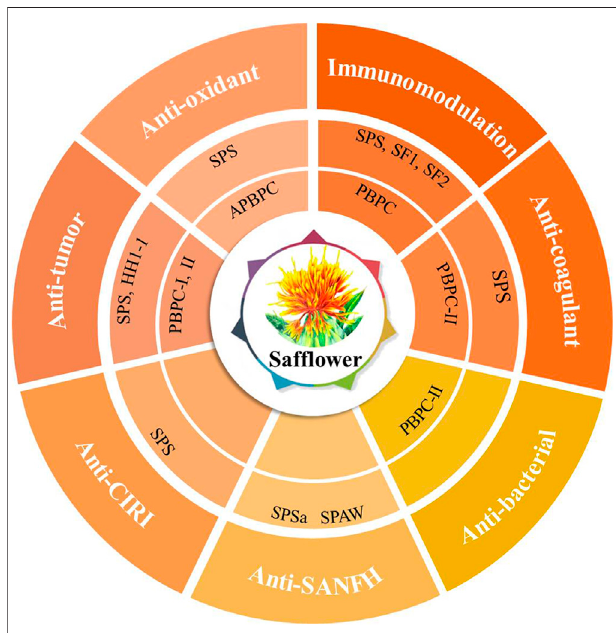
FIGURE 3 | Polysaccharides of saf fl ower and their corresponding bioactivities (CIRI: cerebral ischemia-reperfusion injury; SANFH: Steroid- induced avascular necrosis of the femoral head; SPS: Saf fl ower polysaccharides; PBPC: Polysaccharides of saf fl ower bee pollen; APBPC: Polysaccharide of saf fl ower bee pollen by dilute alkali extraction; Polysaccharidemonomersincluding SPSa , SPAW , HH1-1 , PBPC-I , PBPC- II , SF1 , and SF2